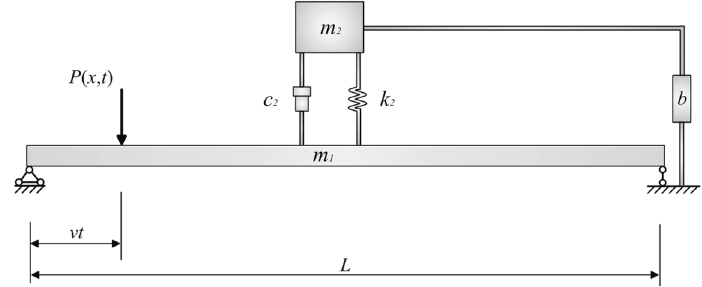
Figure 2. Euler beam with TMDI.